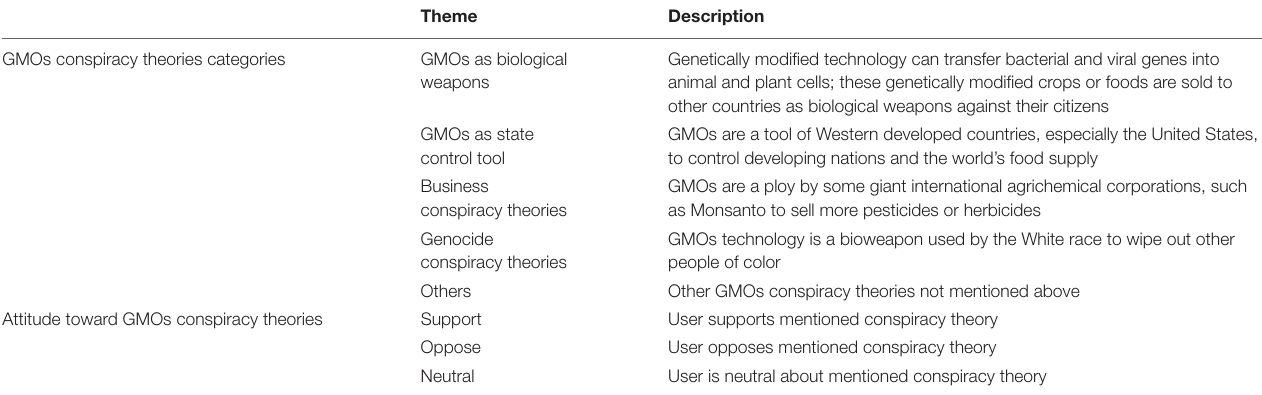
TABLE 1 | Thematic coding books.